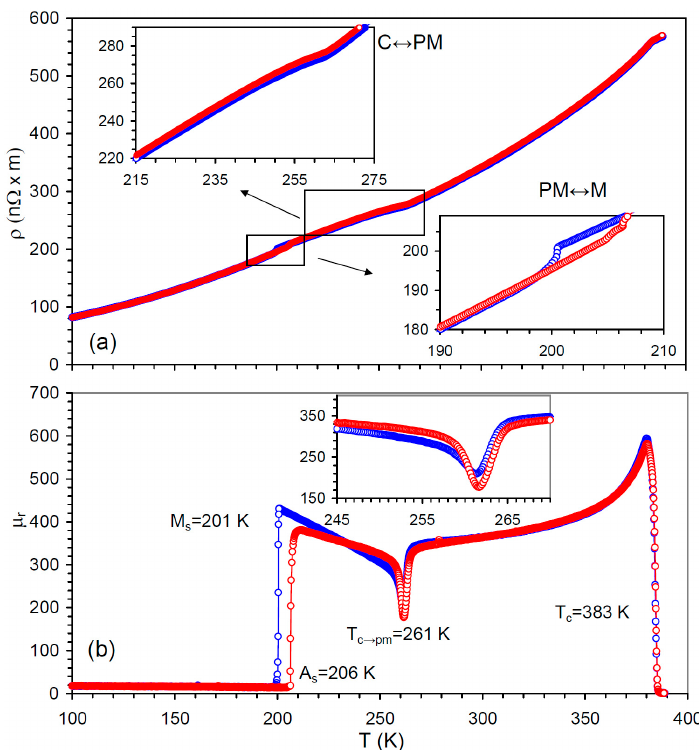
Figure 1. Temperature dependence during cooling (blue symbols) and heating (red symbols) of ( a ) resistivity, ρ , ( b ) reversible permeability µ r , for a single crystalline sample of stoichiometric Ni 2 MnGa. The insets in ( a ) show details of the resistivity behavior during the cubic–premartensite (C ↔ PM) and premartensite–martensite (PM ↔ M) transformations. The Curie temperature T C = 383 K, the temperature of the maximum rate of the C → PM transition, T C-PM = 261 K, and the temperatures of the start of the direct, Ms, and reverse, As, martensitic transformations are indicated in ( b ). The inset in ( b ) shows details of the permeability minimum during C ↔ PM transformation.